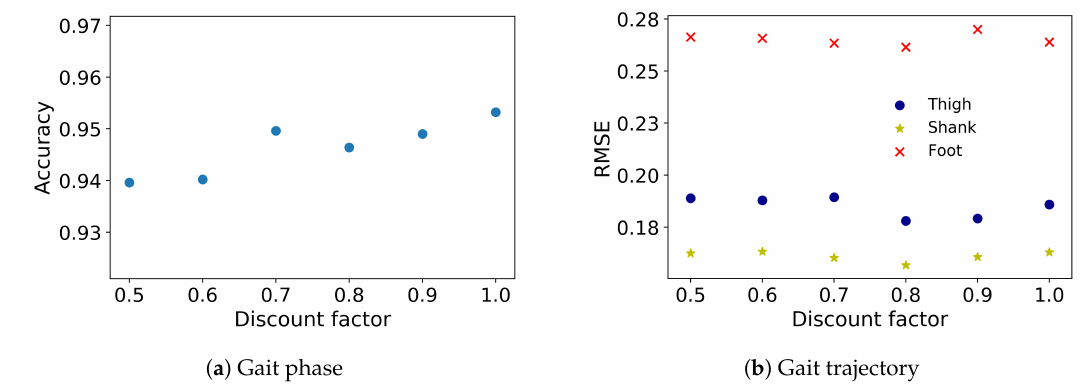
Figure 2. ( a ) Accuracy for gait phases prediction and ( b ) root mean squared error (RMSE) for z-score normalized angular velocities of thigh, shank and foot in 100 ms ahead prediction of one representative subject with respect to different discount factors.